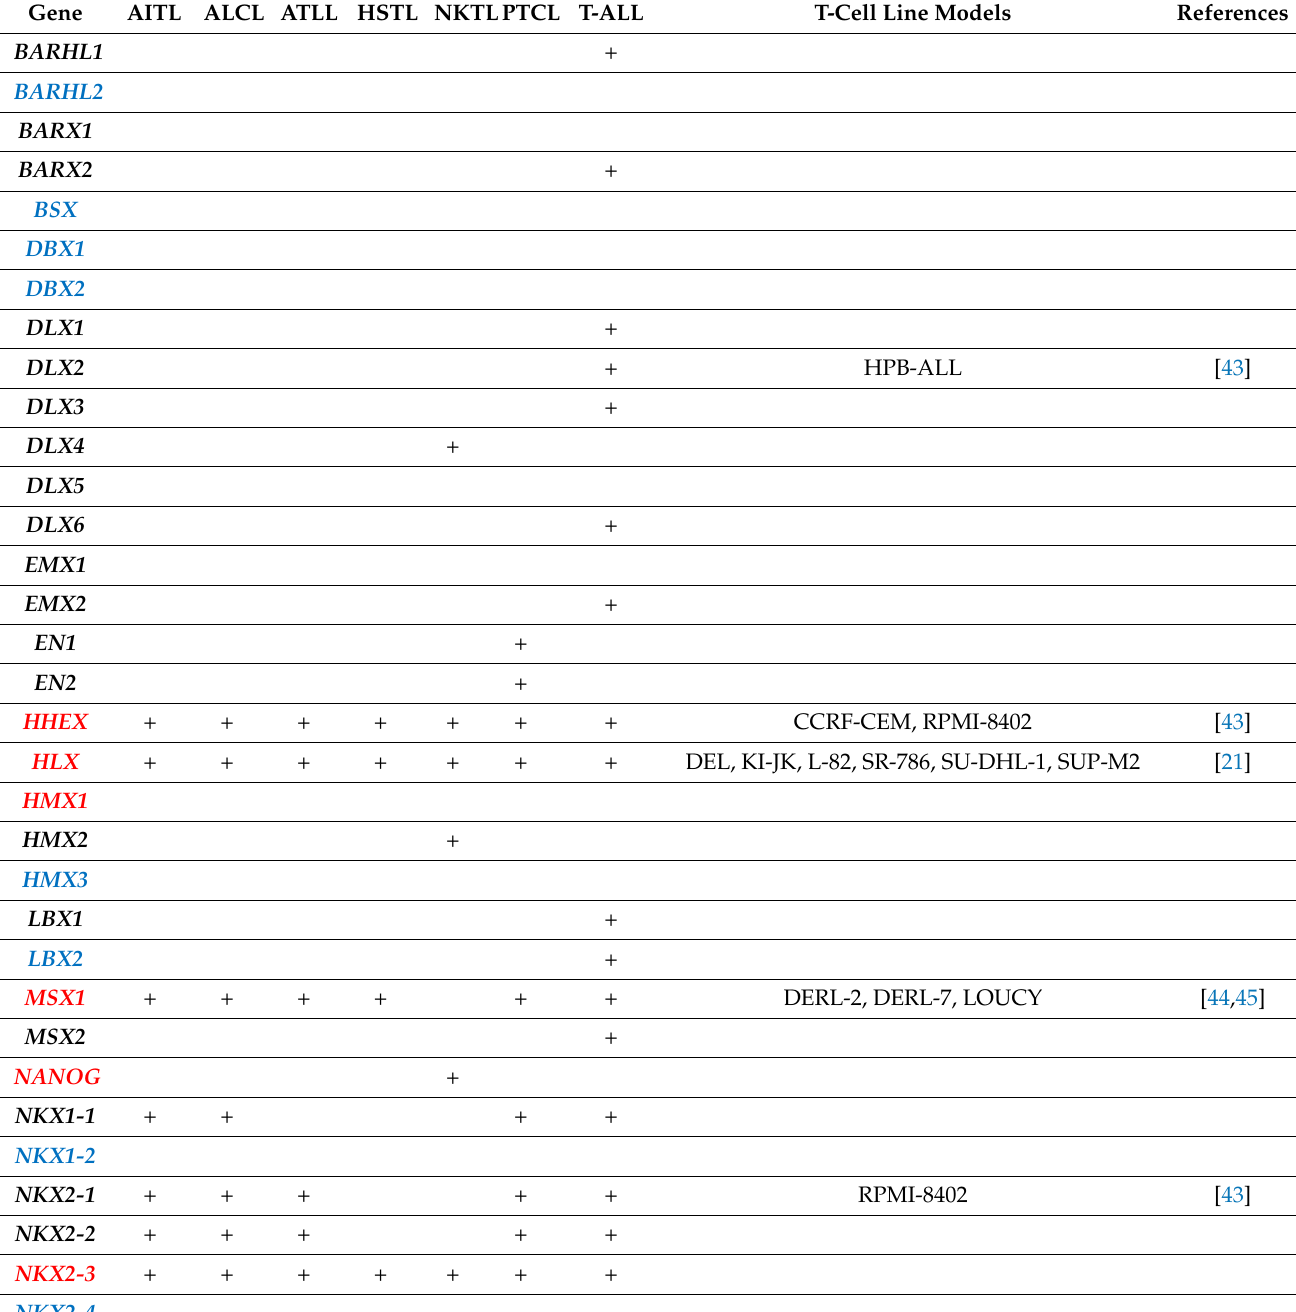
Table 1. Aberrantly expressed NKL homeobox genes in T-cell leukemia/lymphoma patients and cell lines. Gene AITL ALCL ATLL HSTL NKTLPTCL T-ALL T-Cell Line